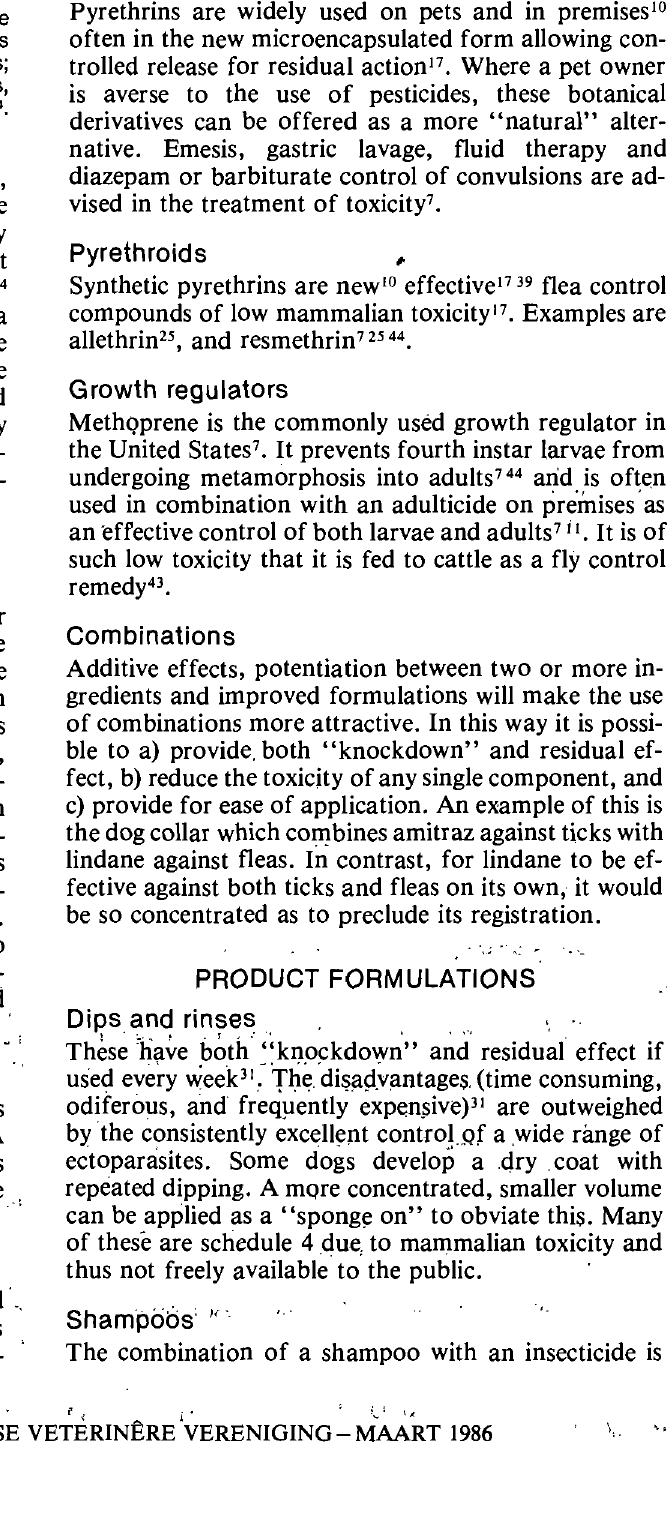
Fig. 1: Diagram of the life-cycle of a flea (from Service48). The lengths of the various stages have been given29 as adult - 200 days; egg - 2 days; larva - 9 to 15 days; pupa - 7 to 21 days. However, under ideal conditions, the life cycle can be completed in as little as 14